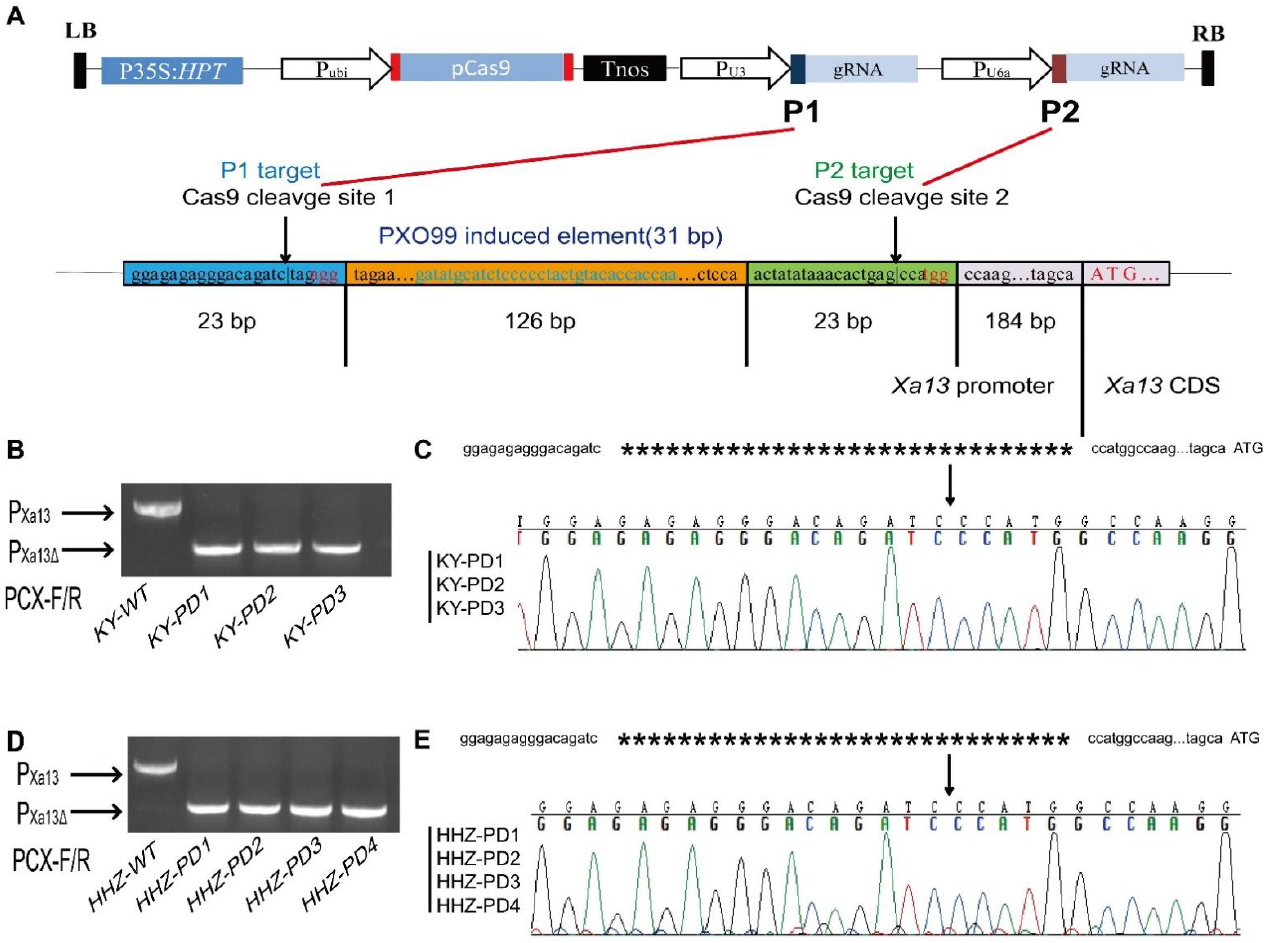
Figure 1. Schematic diagram of promoter editing vector Cas9: P1+P2 and results of the editing of the Xa13 promoter mediated by Cas9: P1+P2 in two conventional rice varieties. ( A ) Schematic description of the wild-type Xa13 promoter. Two target sites (P1 and P2) were located in the promoter region upstream of the Xa13 CDS region. The 31 bp PXO99-inducible element was located entirely between the two target sites (P1 and P2). ( B ) PCR products amplified by primers PCX-F/R to detect the results of the Xa13 promoter edited with the CRISPR/Cas9 system in the T 0 generation of KY131. Three transgenic rice materials (KY-PD1-3), which were completely cut between P1 and P2 by Cas9 protein, were obtained. ( C ) Sequences and chromatograms of the three transgenic plants (KY-PD1-3) after editing. All three transgenic plants (PD1-3) were perfectly connected and repaired after cutting at the two target sites without any base deletion or insertion. ( D ) PCR products amplified by primers PCX-F/R to detect the results of the Xa13 promoter edited with the CRISPR/Cas9 system in the T 0 generation of HHZ. Four transgenic rice materials (HHZ-PD1-4), which were completely cut between P1 and P2 by the Cas9 protein, were obtained. ( E ) Sequences and chromatograms of the four transgenic plants (HHZ-PD1-4) after editing. All four transgenic plants (HHZ-PD1-4) were perfectly connected and repaired after cutting at the two target sites without any base deletion or insertion.